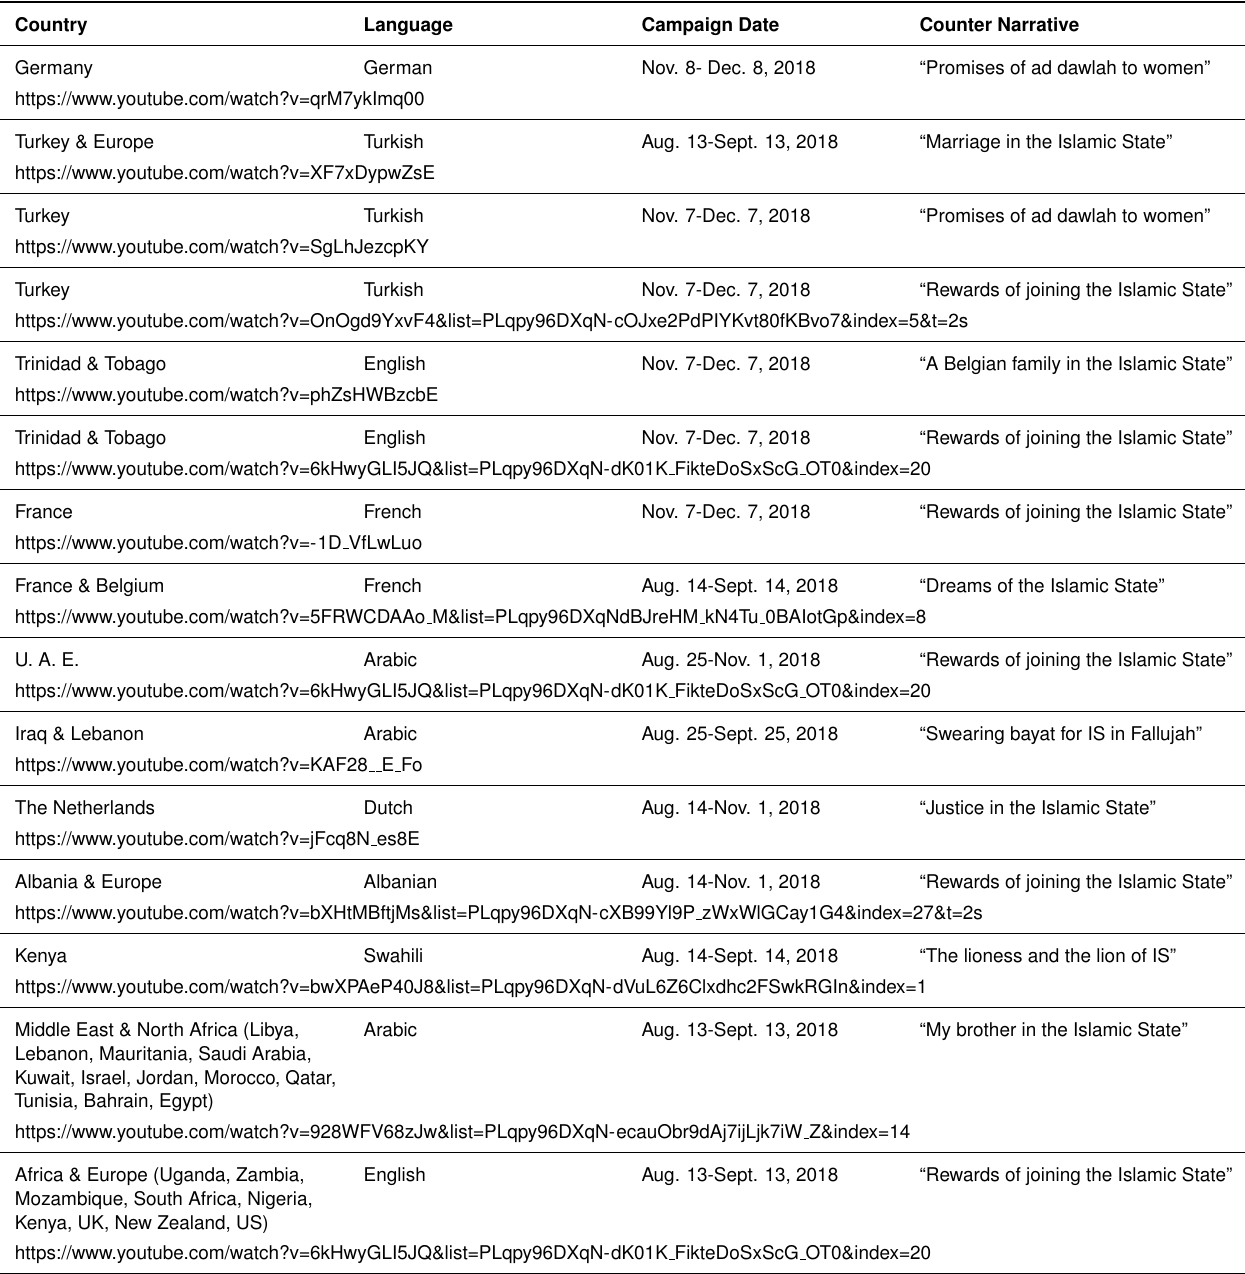
Table 1. Counter narrative campaign